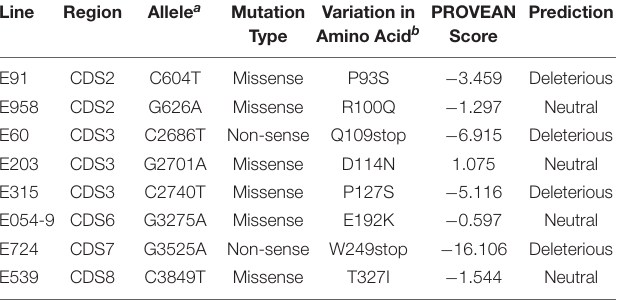
Variation in PROVEAN Type Amino Acid b Score